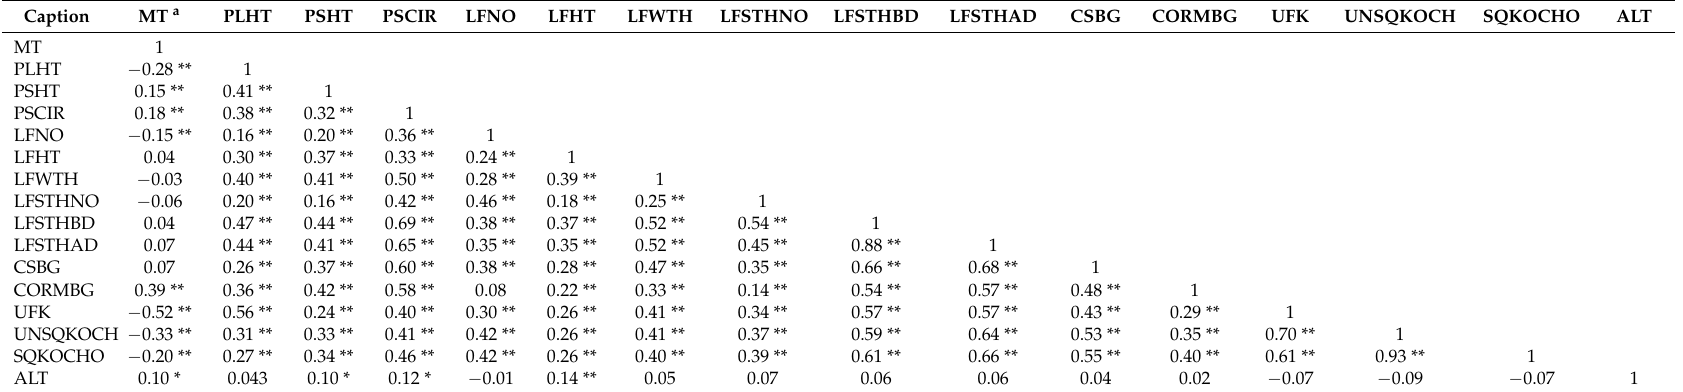
Table 6. Simple correlation coefficients between 15 quantitative characteristics and with altitudes of the collection site based on the mean for 387 enset accessions.